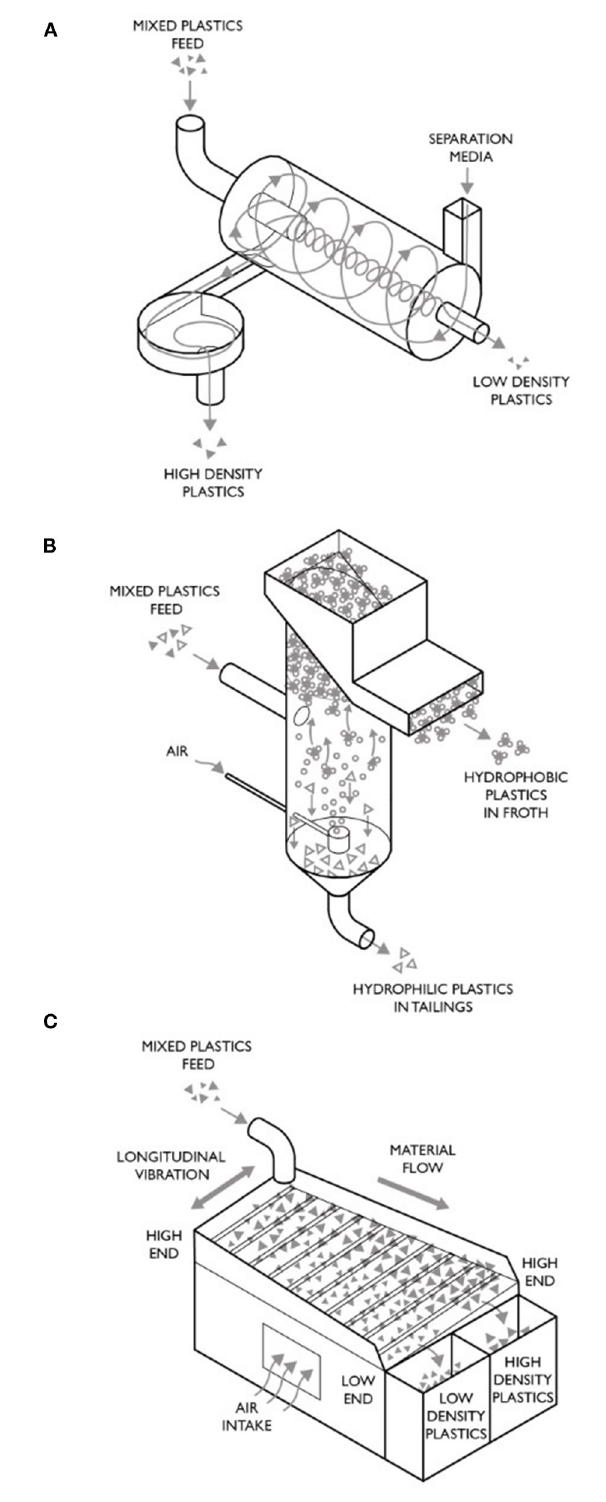
FIGURE 2 | Schematics of sorting mechanisms: (A) hydrocyclone; (B) sink—float and flotation mechanism; (C) air gravity sorting (Vaško,